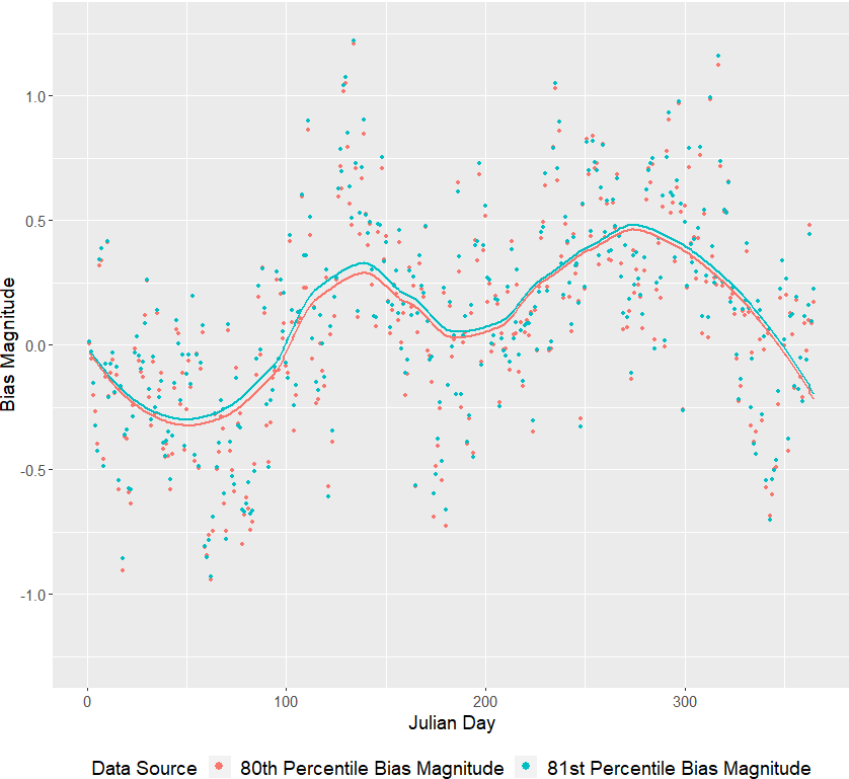
Figure 7. Bias magnitudes of the 80th (red) and 81st (cyan) daily percentiles of log precipitation (mm). This figure was created using Wickham